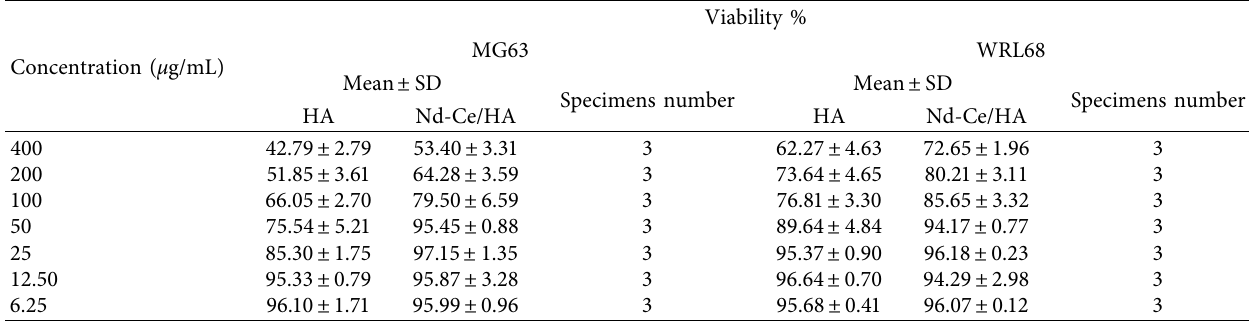
Table 5: Comparison between the cytotoxicity efect of HA and Nd-Ce/HA on cell lines of MG63 and WRL68. Concentration ( μ